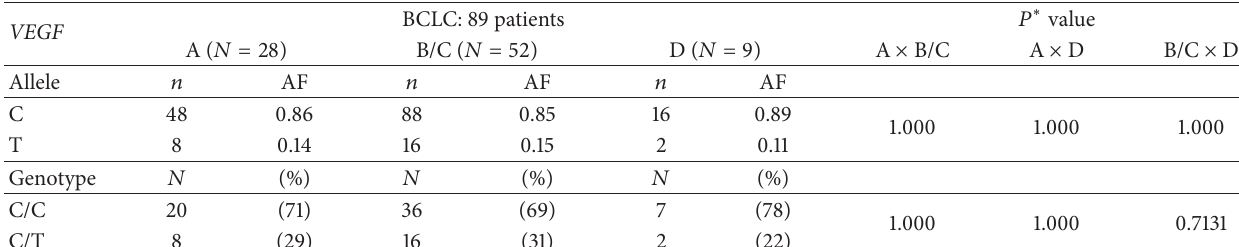
Table 3: Allelic and genotypic frequencies of VEGF -C936T and VEGF -A1154G polymorphisms in patients with hepatocellular carcinoma (G1), considering the BCLC clinical classification.